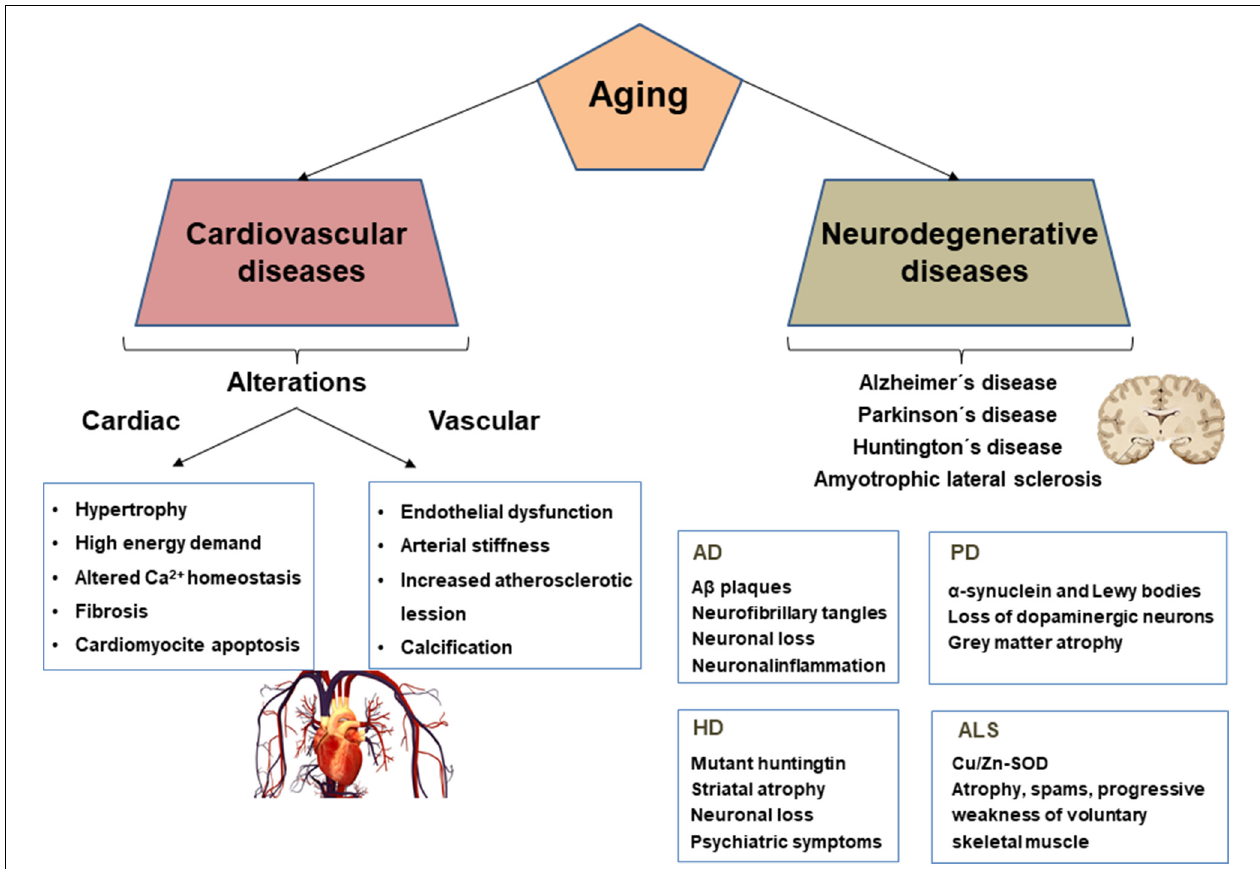
FIGURE 1 | Cardiovascular and neurodegenerative alterations and biomarkers associated with aging. AD, Alzheimer’s disease; PD, Parkinson’s disease; HD, Huntington’s disease; ALS, Amyotrophic lateral sclerosis.